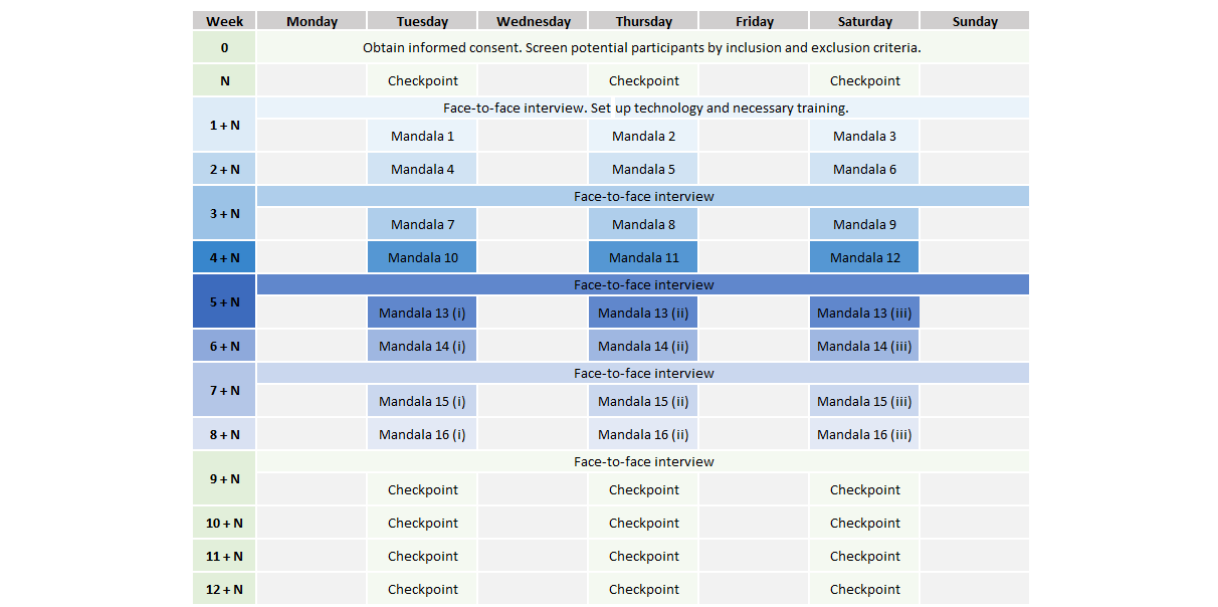
Figure 3. Timeline of the protocol, starting with N weeks of baseline per participant, followed by 8 weeks of intervention and 4 weeks of postintervention monitoring.